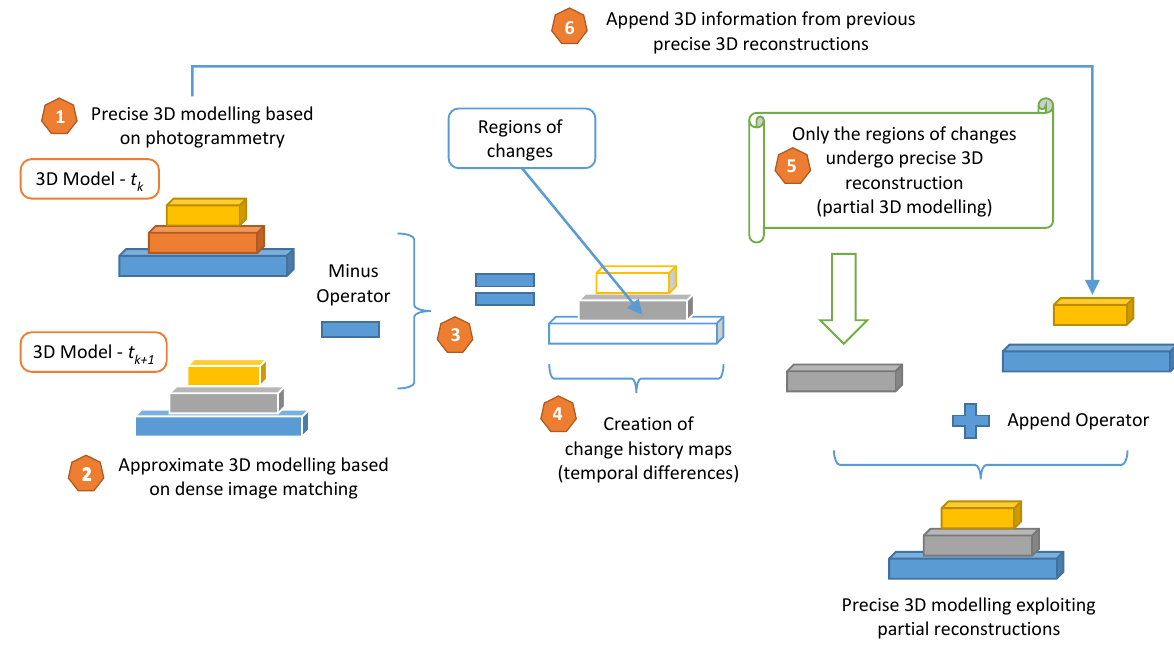
Figure 8. The proposed selective modelling scheme